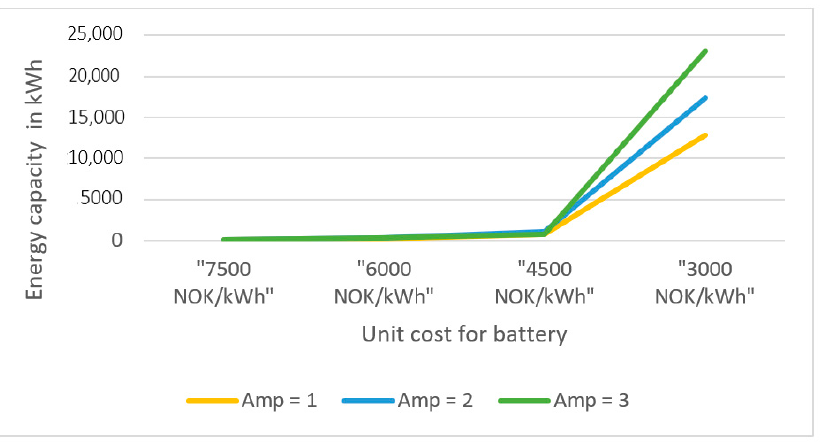
Figure 8. Energy capacity as a function of the demand (amplification factors 1, 2, and 3) and the battery cost.